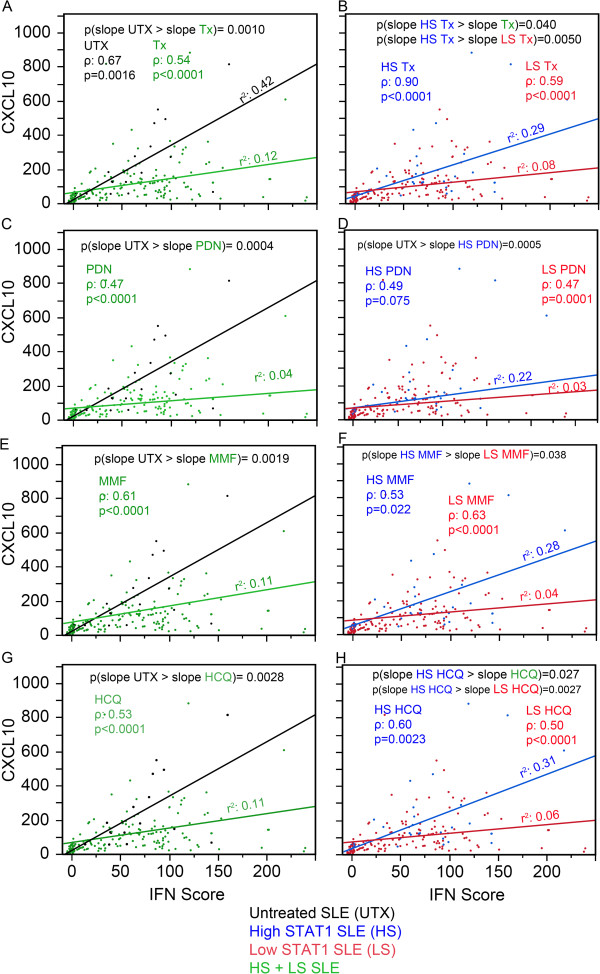
Association between CXCL10, IFN score, and therapy. Data were analyzed as in Figure 6 except that CCL2 was substituted by CXCL10. (A) The relationship of CCL2 versus IFN score presented as a slope was analyzed in untreated (UTX, black) and treated SLE patient visits (Tx, green). Similar analyses were carried out for PDN-treated (C), MMF-treated (E), and HCQ-treated patient visits (G) as well as for high STAT1 (blue) and low STAT1 (red) for Tx (B), PDN-treated (D), MMF-treated (F), and HCQ-treated patient visits (H). CCL2, C-C motif chemokine ligand 2; CXCL10, C-X-C motif chemokine 10; HCQ, hydroxychloroquine; IFN, interferon; MMF, mycophenolate mofetil; PDN, prednisone; SLE, systemic lupus erythematosus; SLEDAI, SLE disease activity index; STAT1, signal transducer and activator of transcription 1.